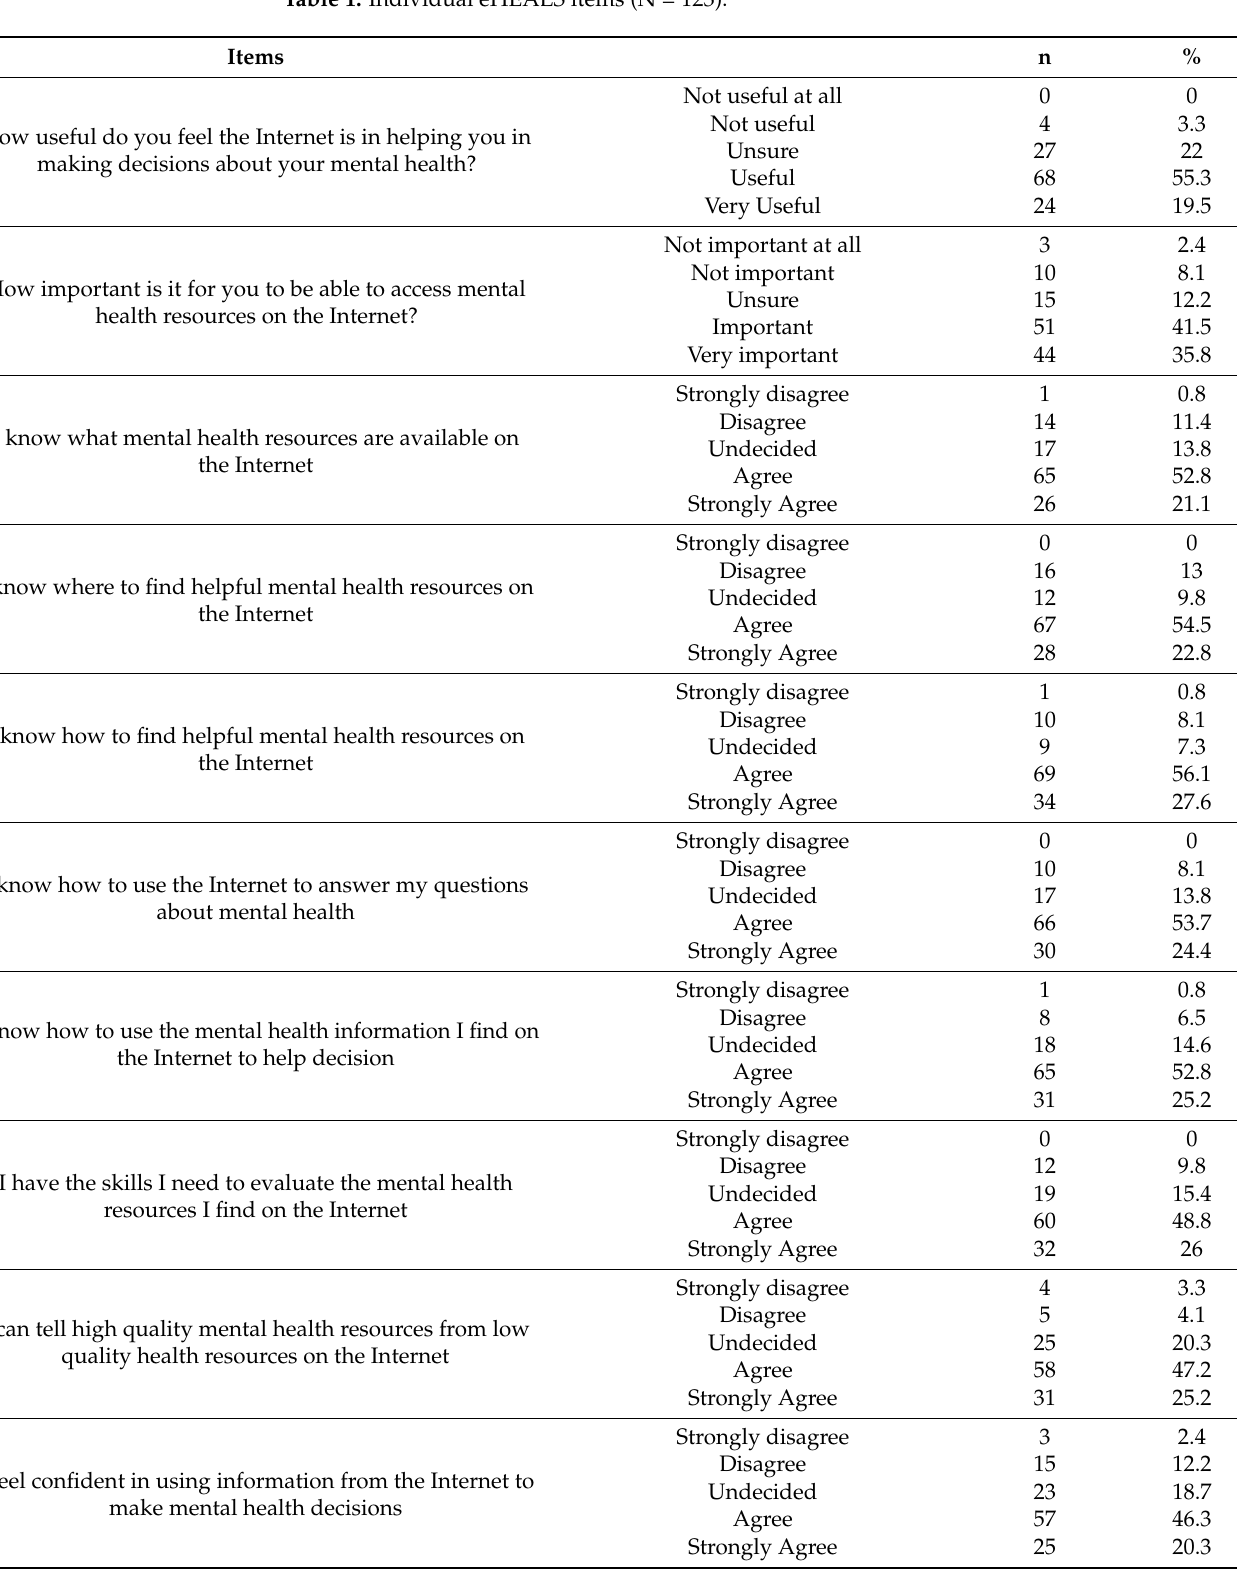
Table 1. Individual eHEALS items (N =